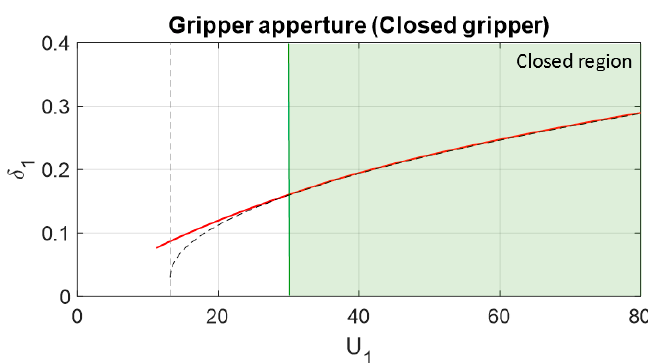
Figure 23. Comparison between the theoretical and simulated actuator displacement compared with the actuator energy when the gripper is already closed.